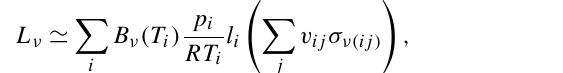
Fig. 7. Temperature variation about a global (left), 60 ◦ (middle) and 30 ◦ (right) latitude bin profiles for the MIPAS MA mode days available in June, July and August for 2007, 2008 and 2009.